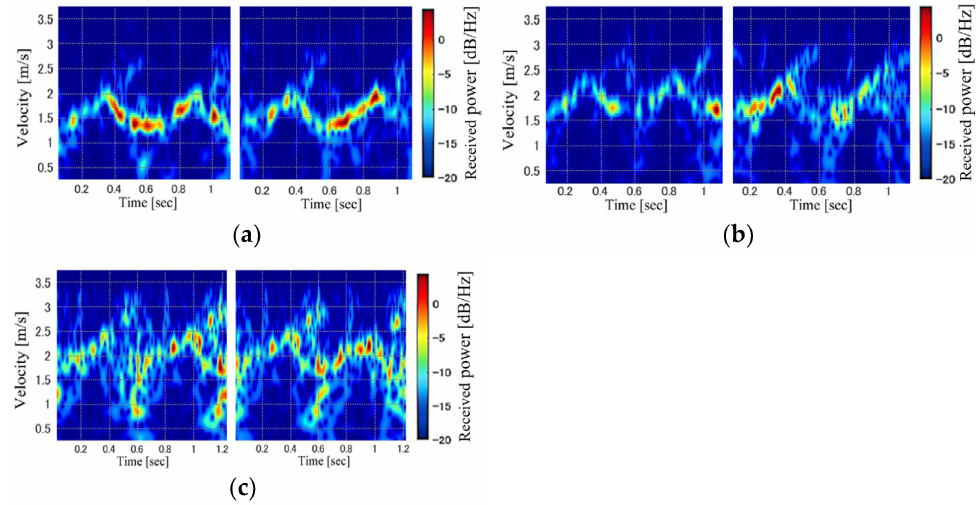
Figure 2. Examples of STFT spectrogram images. Each panel corresponds to a different participant (subfigures ( a – c ) show the spectrogram images of participants ( a ), ( b ), and ( c ), respectively).